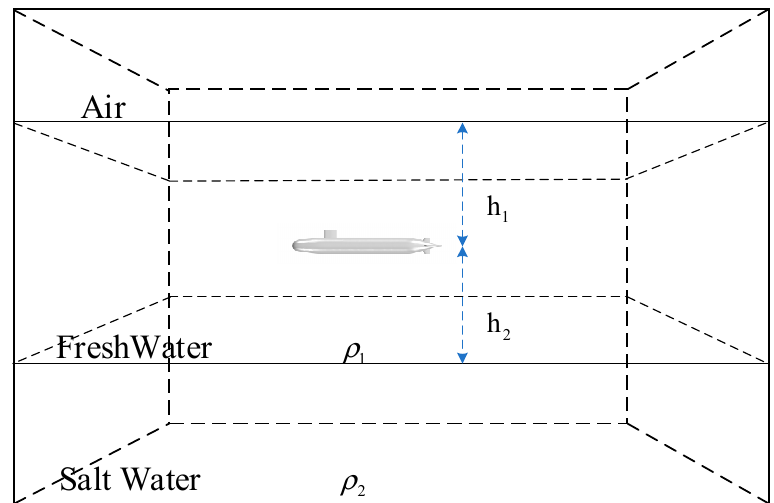
Figure 8. Schematic diagram of fluid density stratification.